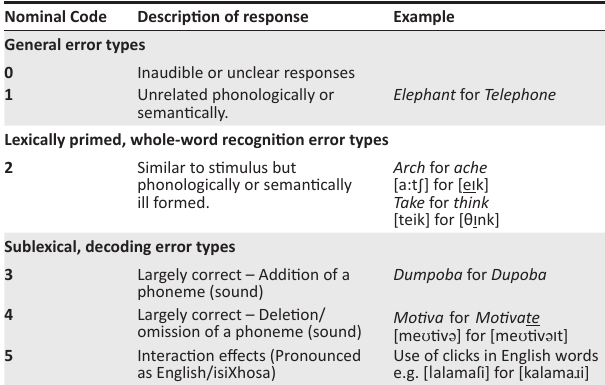
TABLE 3: Nominal scale used for coding